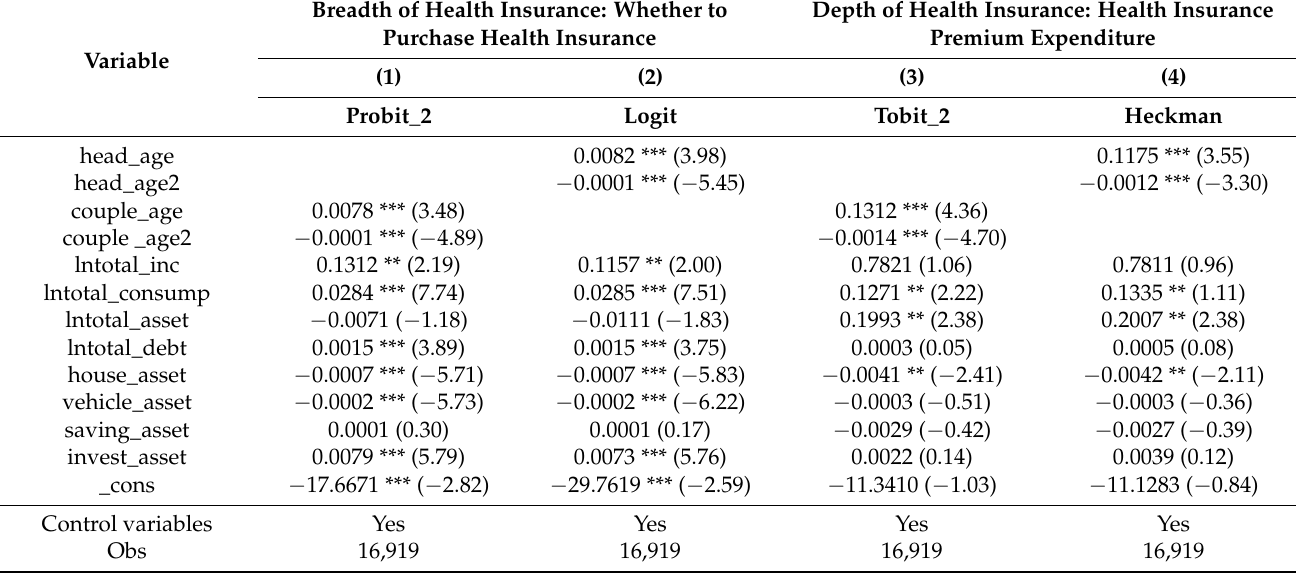
Table 7. Robustness test of the model.